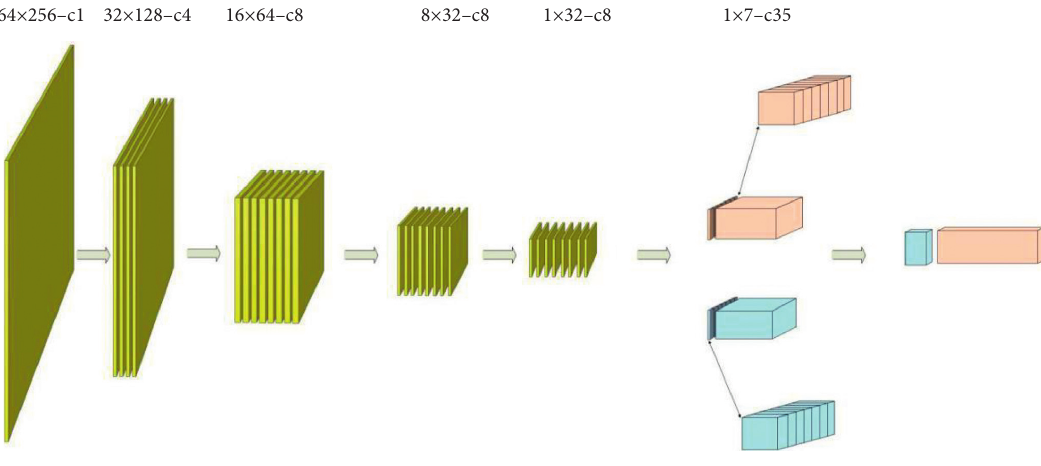
Figure 3: Fast-LPRNet structure diagram.